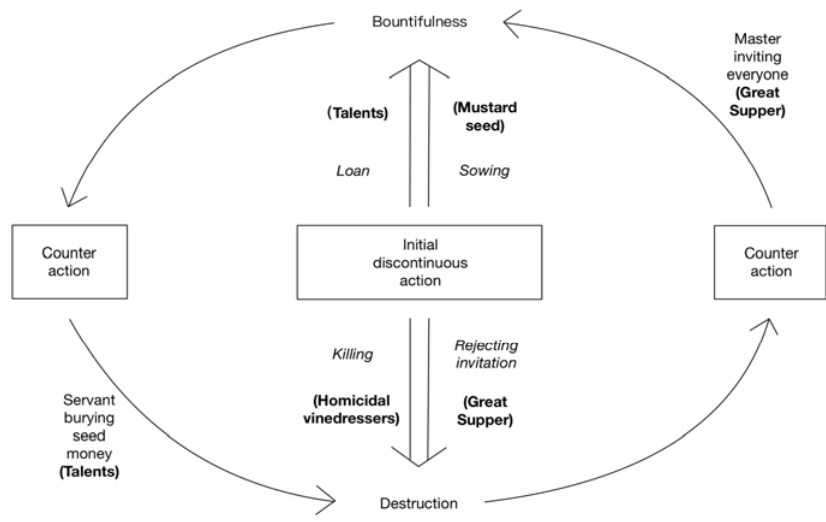
Figure 1. Meta ‐ narrative suggested by the crisscrossing of four core storylines. Figure 1. Meta-narrative suggested by the crisscrossing of four core